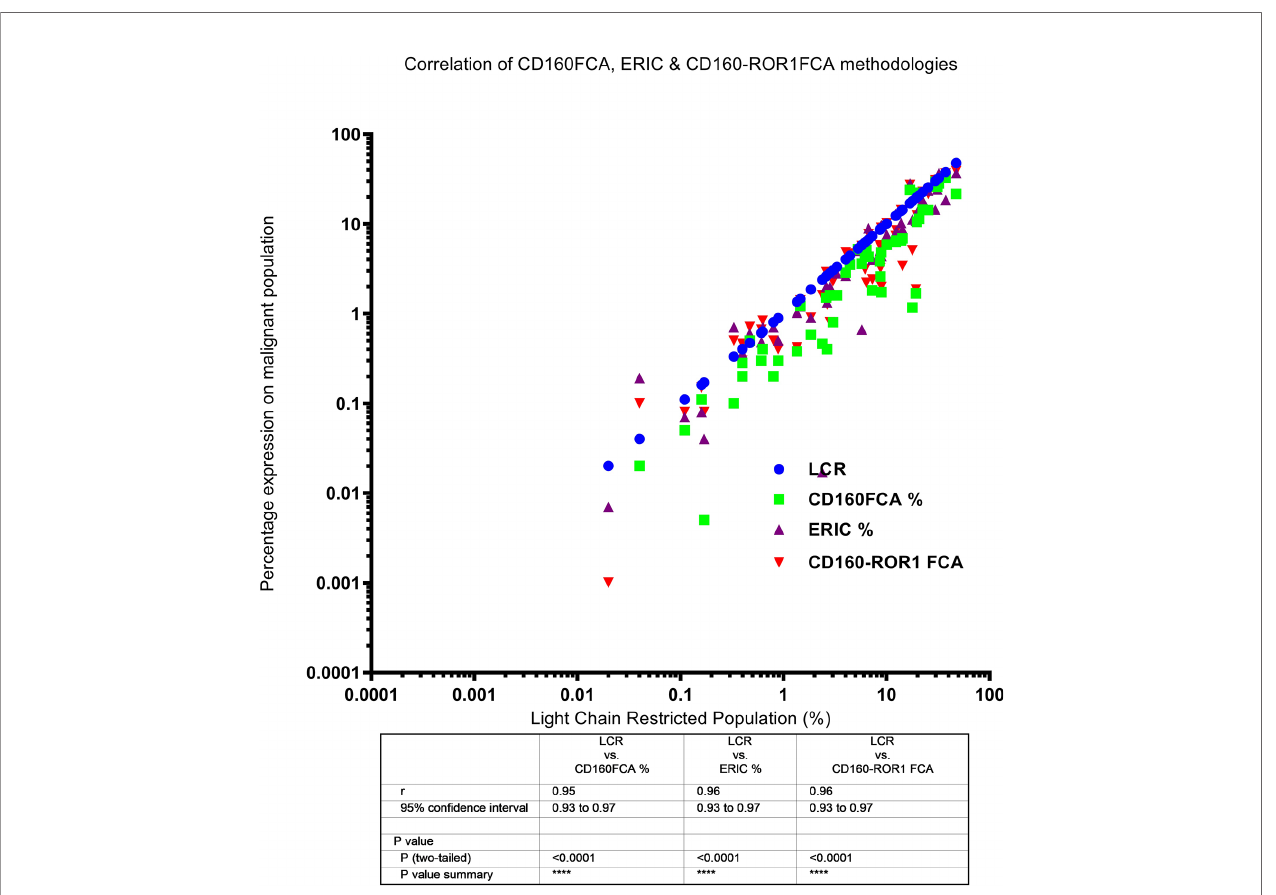
FIGURE 2 | Correlation of light chain restriction and MRD detection by CD160FCA, the ERIC protocol and CD160-ROR1FCA. Light chain restriction (LCR, shown as blue dots) was detectable in 24 patients. The percentage MRD expression is plotted for each of the assays against the percentage of the LCR-restricted population: CD160FCA – green squares; ERIC – purple triangles; CD160-ROR1FCA – red triangles. There was excellent correlation between level of LCR and detectable disease with all the assays (p <